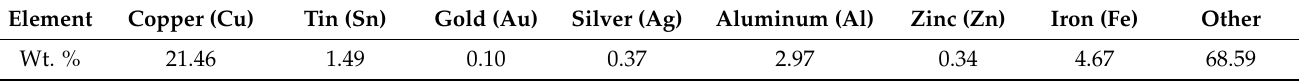
Table 2. The elemental composition of spent PCB.